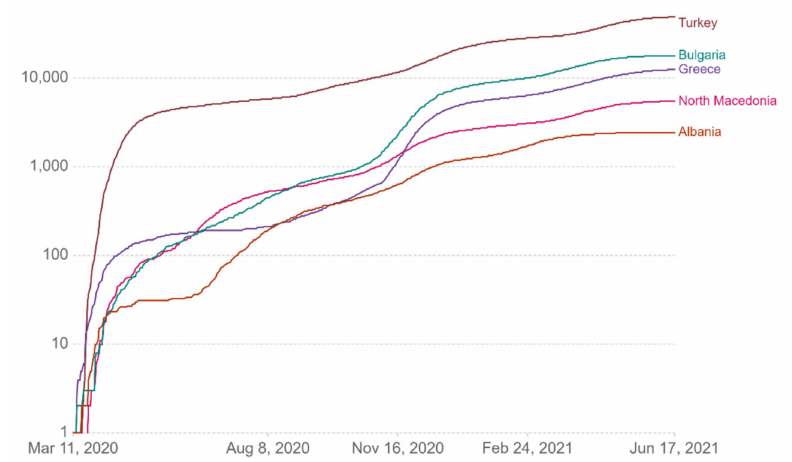
Figure 9. Cumulative confirmed deaths per million.